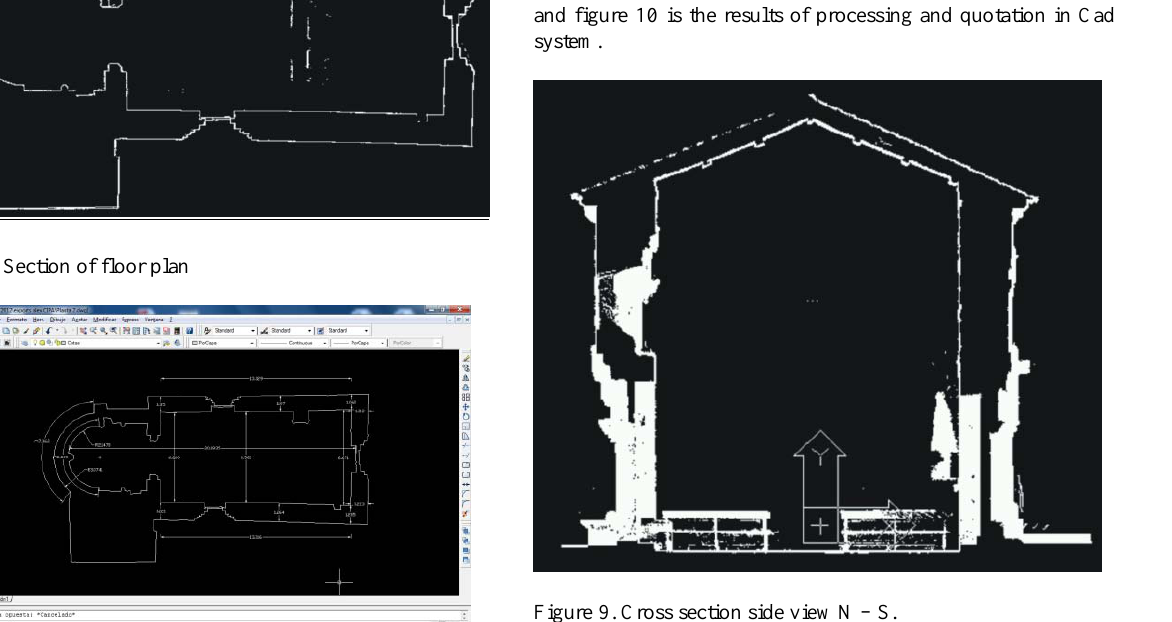
Figure 9. Cross section side view N – S.